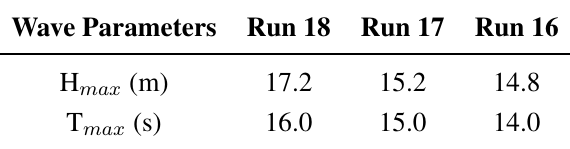
Table 1. Wave parameters in the prototype